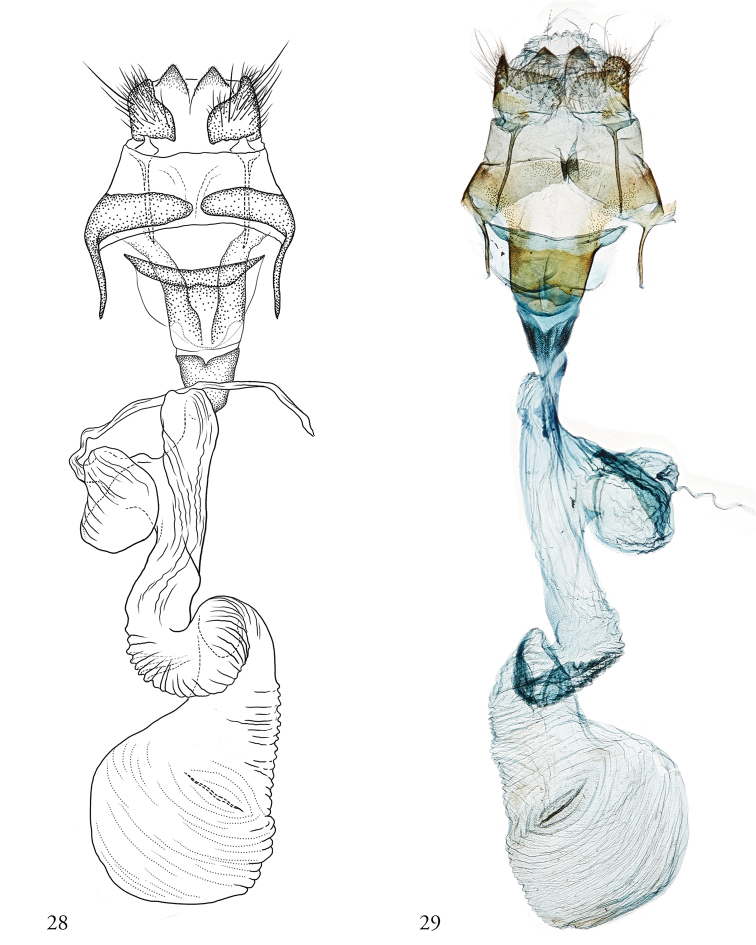
Female genitalia. 29USNMENT01463999, 11-SRNP-42773, Dissection #148174 (ink) 30USNMENT01463999, 10-SRNP-46180, Dissection #148173.